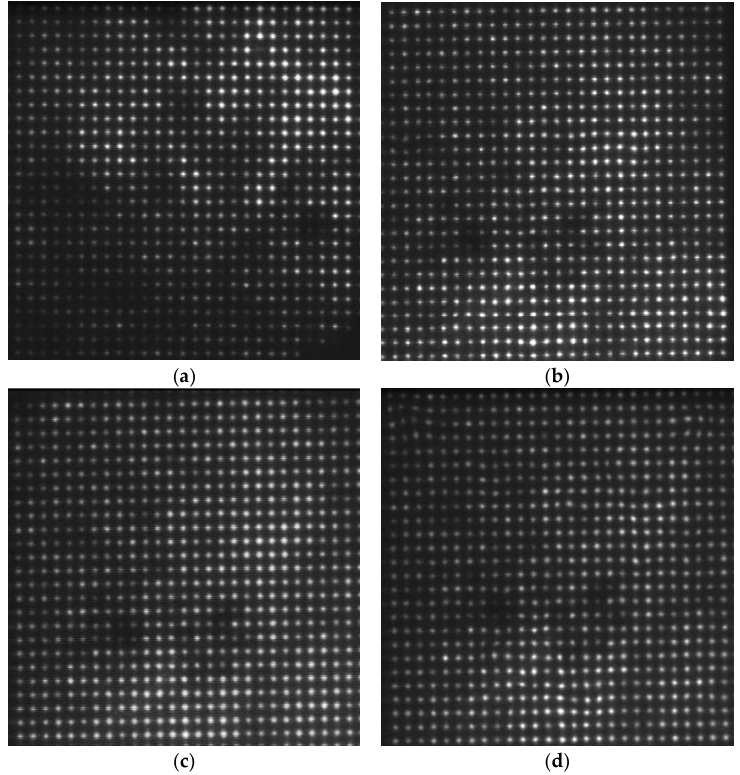
Figure 8. Focal spot images acquired from different distances. ( a ) Focal spot image from 1 m; ( b ) focal spot image from 2 m; ( c ) focal spot image from 3 m; ( d ) focal spot image from 4 m.